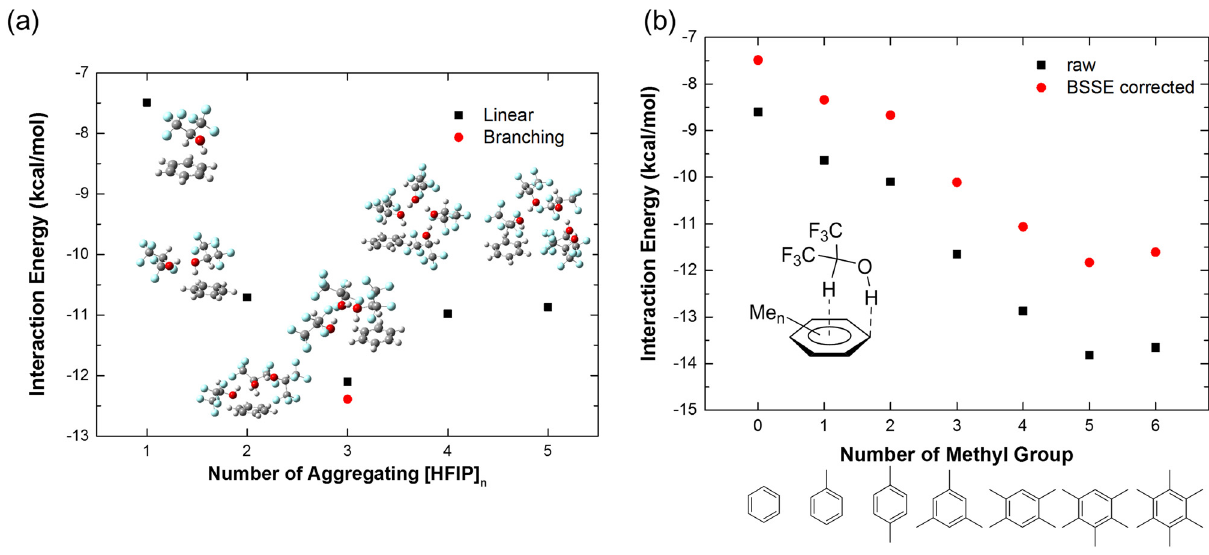
Figure 4. The interaction energies (kcal/mol) of ( a ) [HFIP]n/PhH complexes (n = 1–5) with BSSE correction and ( b ) HFIP/PhMen (n = 0–6) with and without BSSE correction.